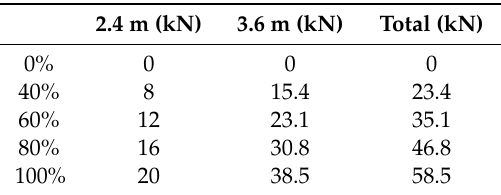
Figure 2. Load test of the blade: ( a ) Workshop test; ( b ) Loading scheme. Table 1. Steps of the load test.